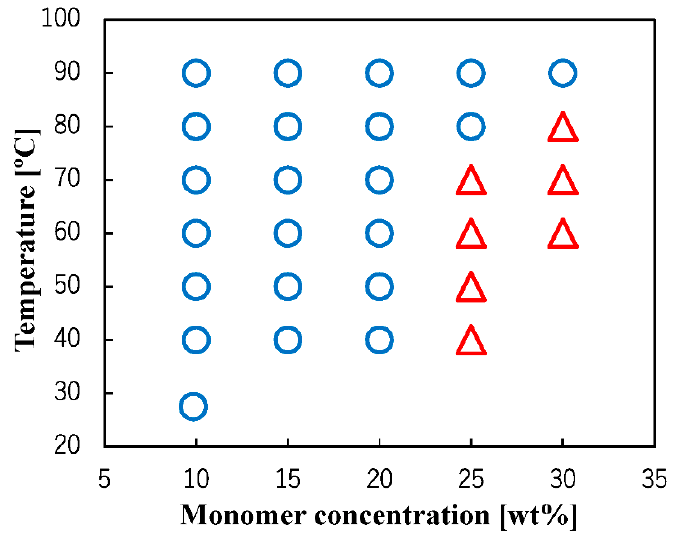
Figure 1. Production diagram of state of AM4-HDA system Case I (feed molar ratio of AM4/HDA: Production diagram of state of AM4-HDA system Case I (feed molar ratio of 1/2), ○ porous polymer, △ gel. AM4/HDA: 1/2), porous polymer, (cid:52) (cid:35)